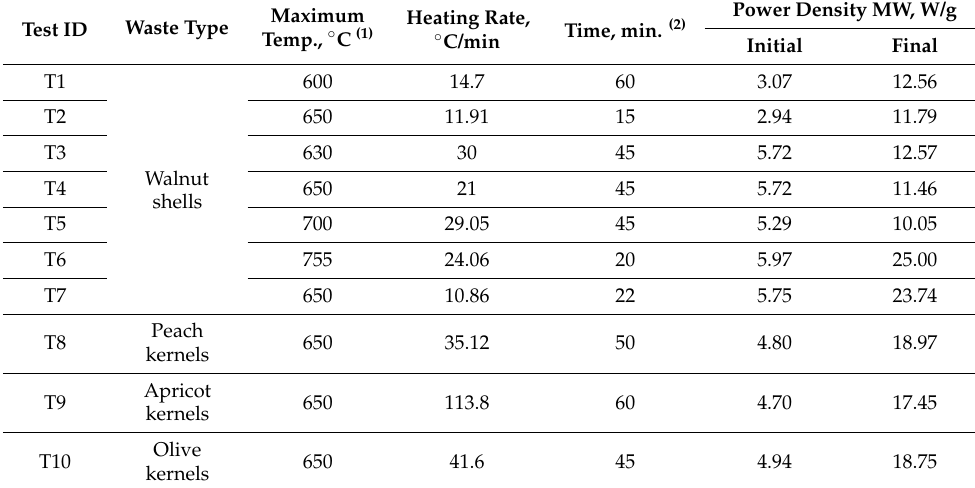
Table 4. Operational parameters run during the laboratory